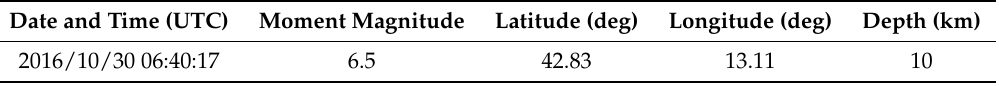
Table 1. Earthquake hypocenter coordinates and origin time (from Centro Nazionale Terremoti-Instituto Nazionale Geofisica e Vulcanologia